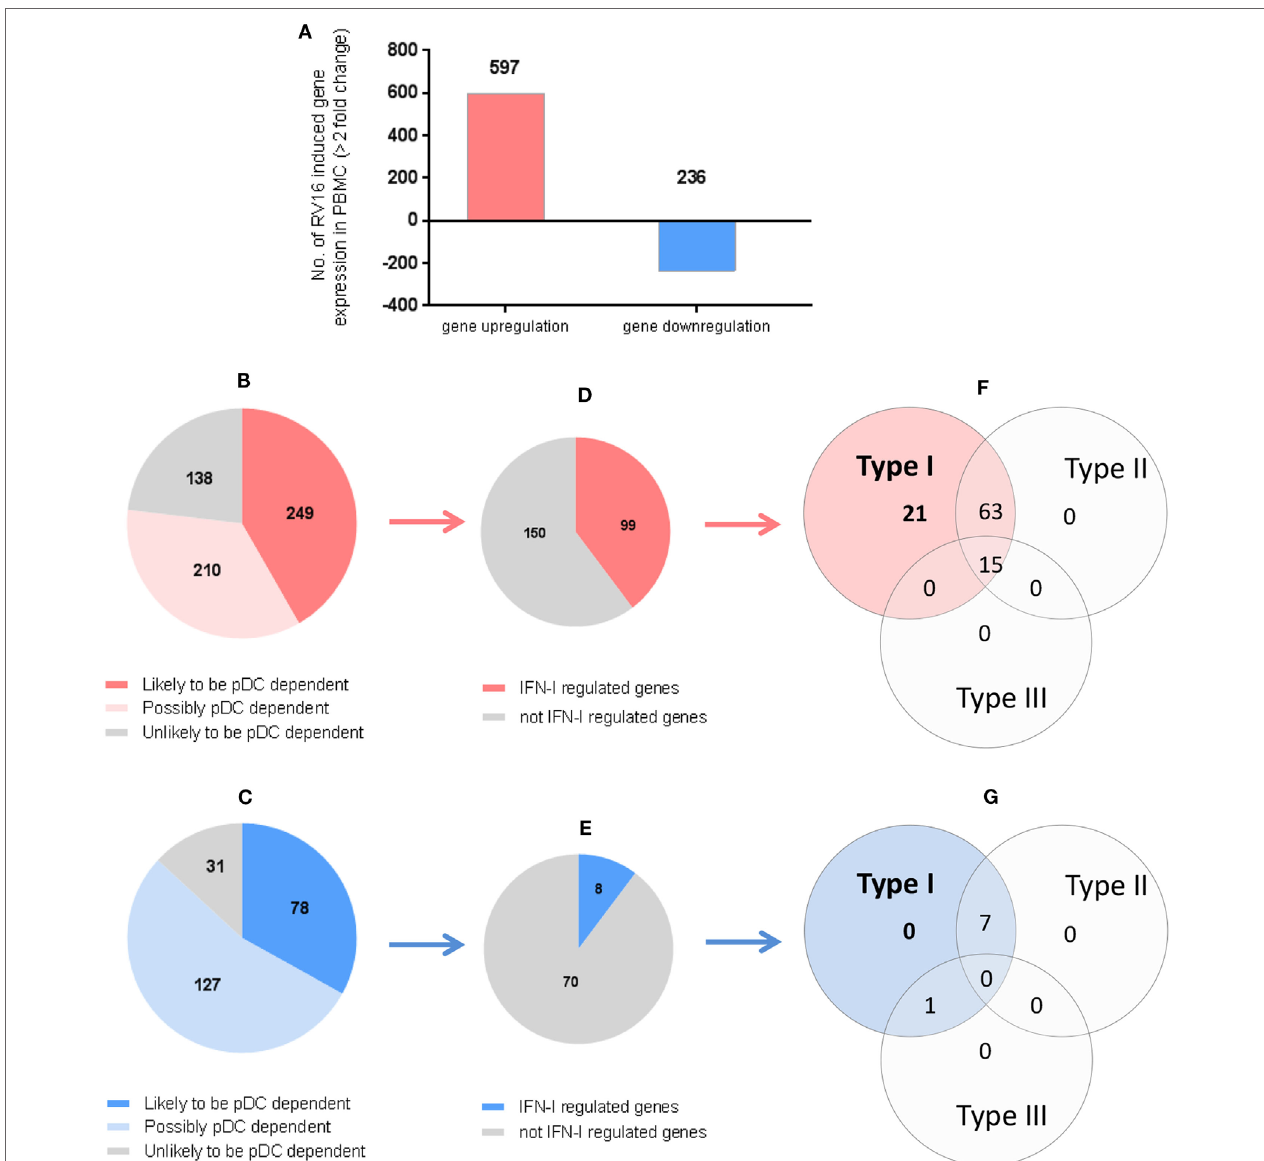
FigUre 4 | Which human rhinoviruses strain 16 (RV16) responsive genes are dependent on Plasmacytoid dendritic cell (pDC) and regulated by interferon (IFN)-I? RV16 responsive genes showing > 2-fold changes have been analyzed (a) . Out of the total genes that are upregulated (Red) or downregulated (Blue), the numbers of pDC-dependent gene expressions have been analyzed by comparing pDC-depleted PBMC with intact PBMC. Genes that show > 2-fold change are regarded as “likely to be pDC dependent”; between 1.5- and 2.0-fold changes are regarded as “possibly pDC dependent”; and < 1.5-fold change and regarded as “unlikely to be pDC dependent” Numbers of genes are indicated on the pie charts (B,c) . Out of the total genes that are likely to be pDC-dependent expression ( > 2-fold), the proportion of IFN-I-regulated gene expression has been identified using Interferome v2.01 database: (D,e) . Venn diagrams show the extent to which IFN-I-regulated genes are regulated solely by IFN-I, or also regulated by multiple IFN subtypes (F,g)